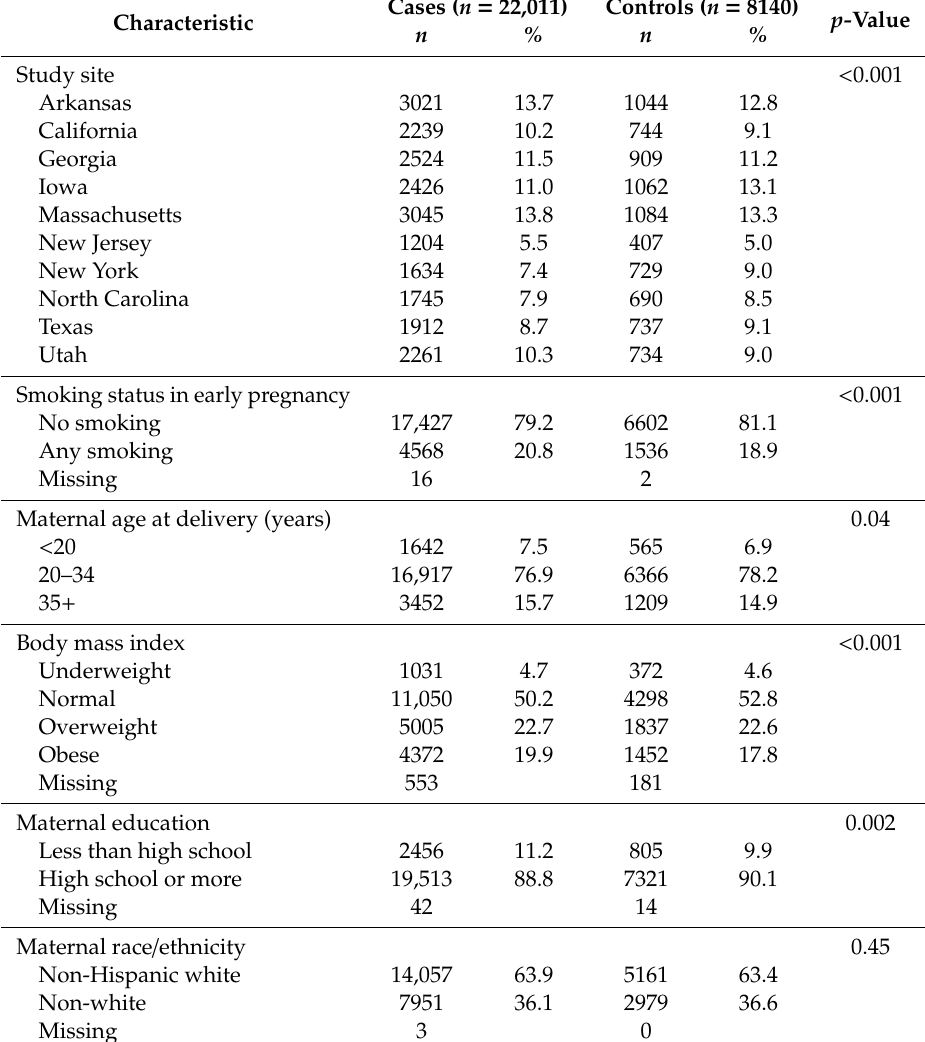
Table 1. The demographic characteristics of case mothers of infants with isolated birth defects and control mothers of infants without birth defects, NBDPS,